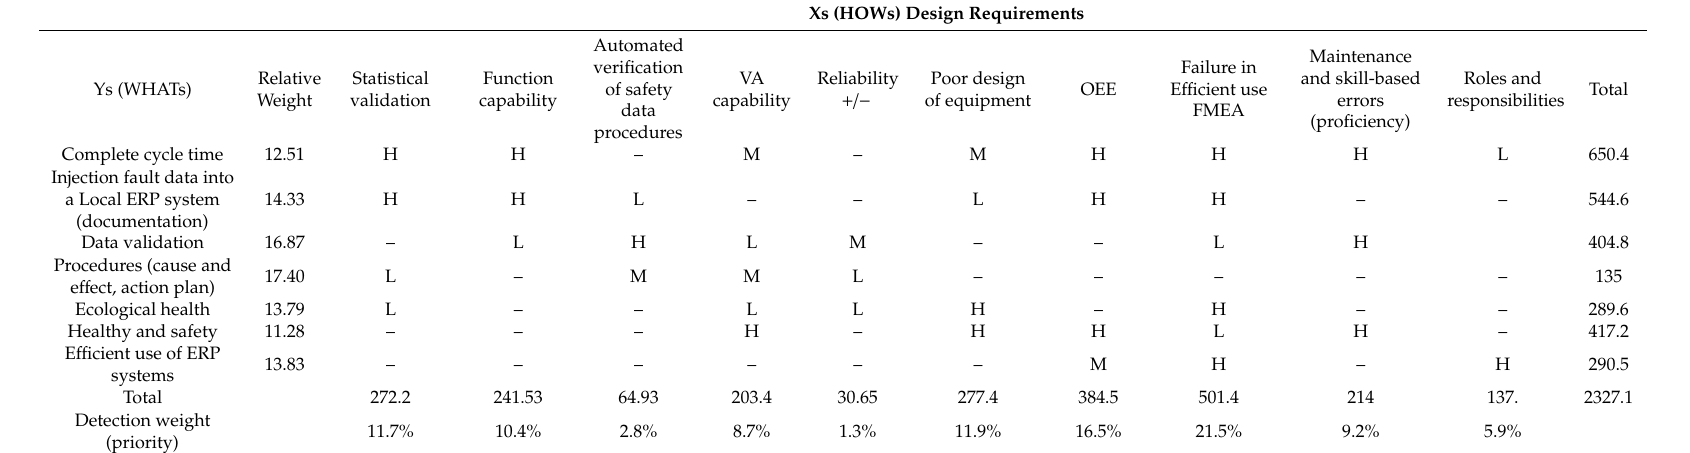
Table 7. Safety Function Deployment (Step 3).